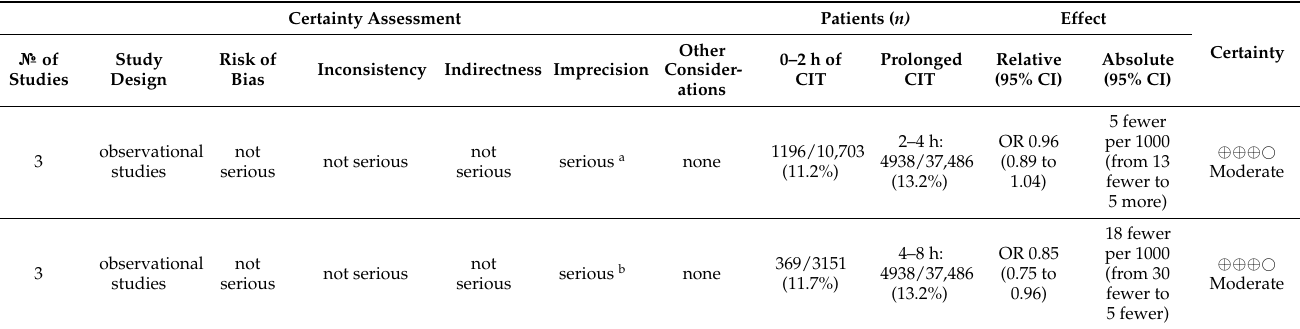
Table A7. Summary of findings with the level of evidence estimated by the Grade-tool for 5-year graft survival.